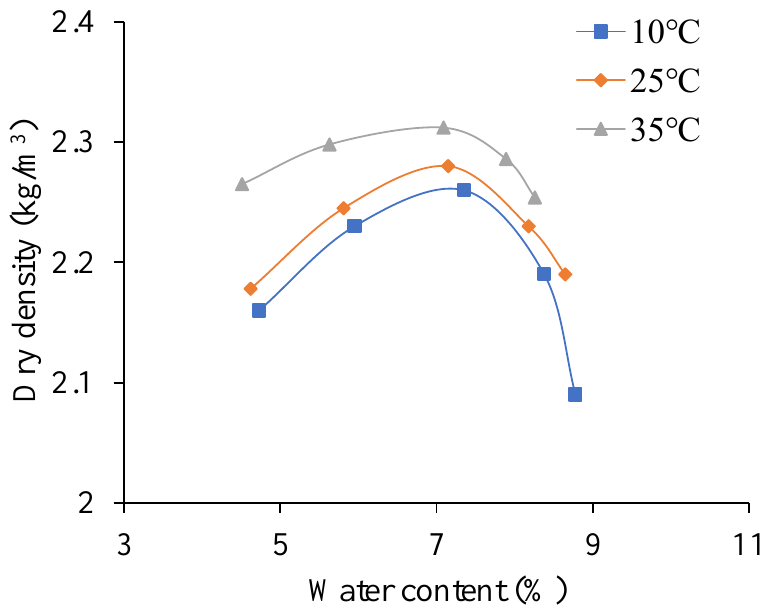
Figure 7. The relationship curves between water content and dry density.